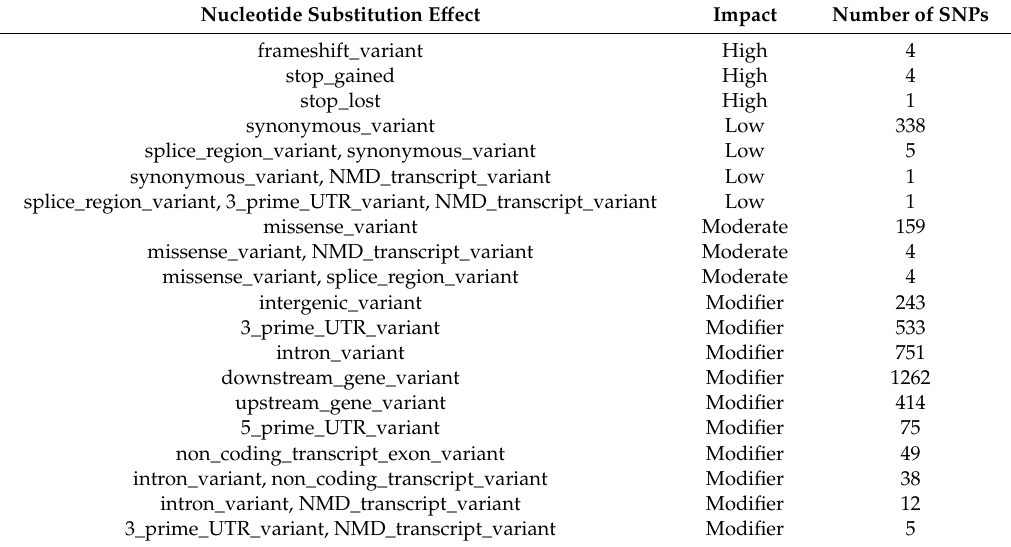
Table 2. The classification of SNP e ff ects that can influence the accelerated-aging phenotype in OXYS rats.